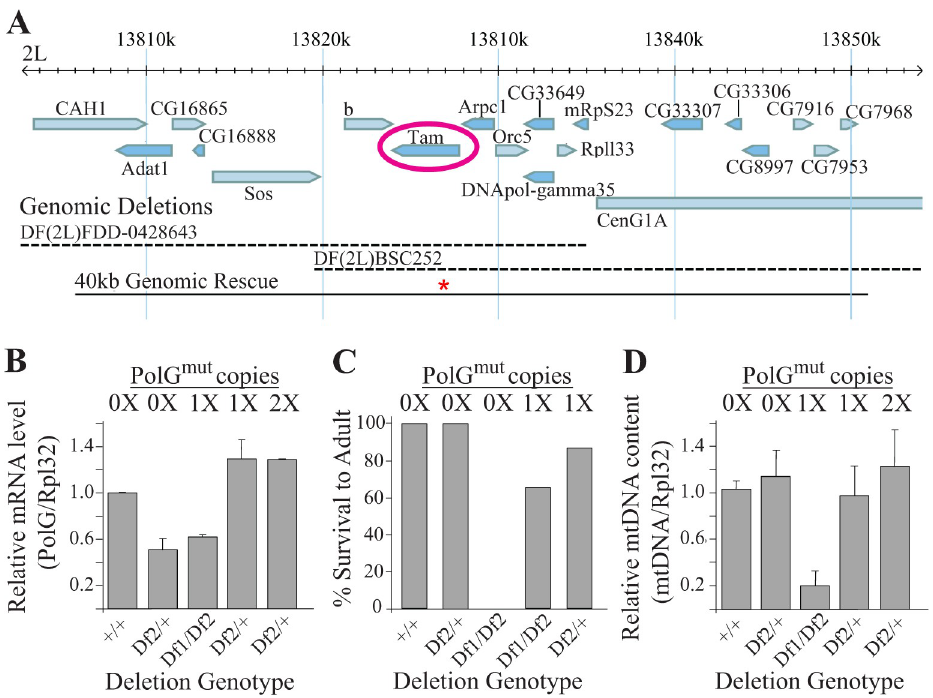
Fig 1. Transgenic expression of an exonuclease-deficient PolG rescues the larval lethality caused by overlapping deletions that remove Drosophila PolG . (A) The genomic region containing the Drosophila PolG gene tamas ( tam ). Blue bars represent known or predicted transcripts. Dashed lines correspond to sequences eliminated by the deletion alleles Df(2L)FDD-0428643 (DF1) and Df(2L)BSC252 (DF2). The solid black bar corresponds to the 40kb transgenic construct containing the D263- > A263 mutation in Drosophila PolG (designated by the red asterisk), which spans the overlap between the Df(2L)FDD-0428643 and Df(2L)BSC252 deletions. (B) Total RNA was extracted and qPCR was used to measure PolG and Rpl32 transcript abundance from 7-day-old flies of the given genotype (n = 4 per genotype, three independent replicates) and their ratios are indicated. (C) The percentage of larvae of the given genotype that survived until the adult stage of development is indicated (n � 236 flies per genotype). (D) DNA was extracted from 7-day-old flies and qPCR was used to measure COX1 and Rpl32 DNA abundance from flies of the given genotype (n = 2 7-day-old male flies per genotype, three independent replicates) and their ratios are indicated. Error bars in panels B and D represent standard error.